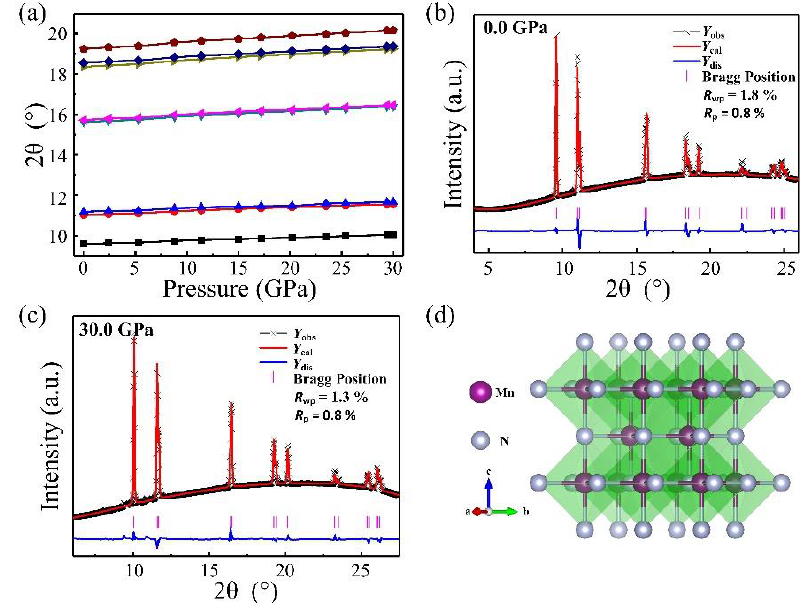
Figure 2. ( a ) X-ray diffraction lines’ evolution with pressure; ( b ) crystal structure of MnN; Rietveld refinement of the XRD pattern of the MnN sample at ( c ) 0.0 GPa and ( d ) 30.0 GPa, respectively.